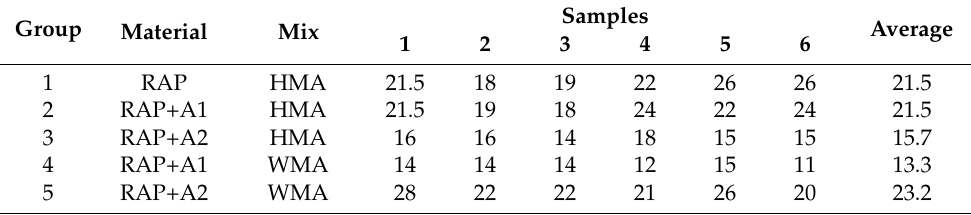
Table 3. Number of gyrations applied for compacting HWT samples at 7% air